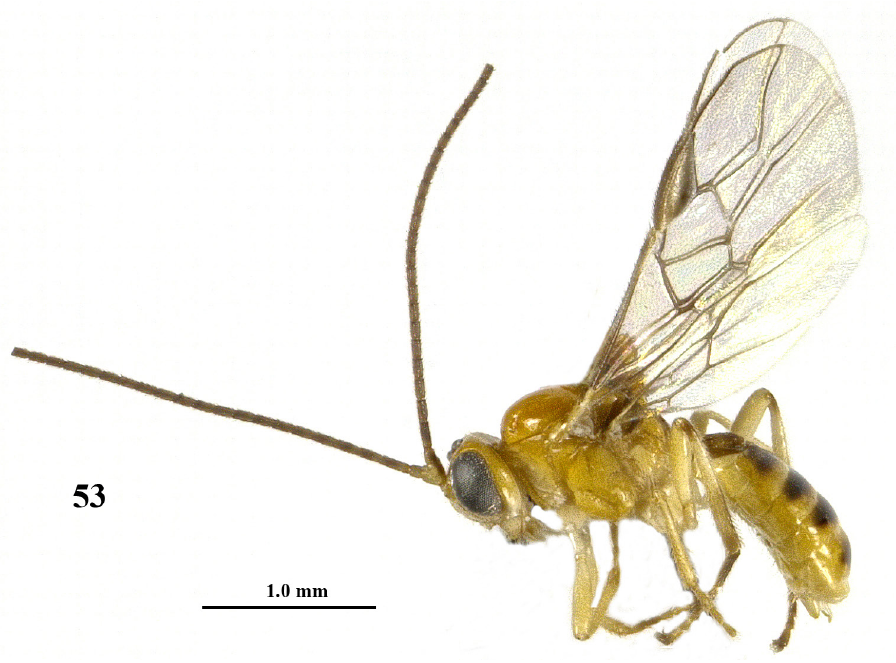
Figure 53. Psyttalia majocellata sp. n., ♂ paratype, habitus (Fig. 49); malar suture largely absent; malar space 0.4 times longer than basal width